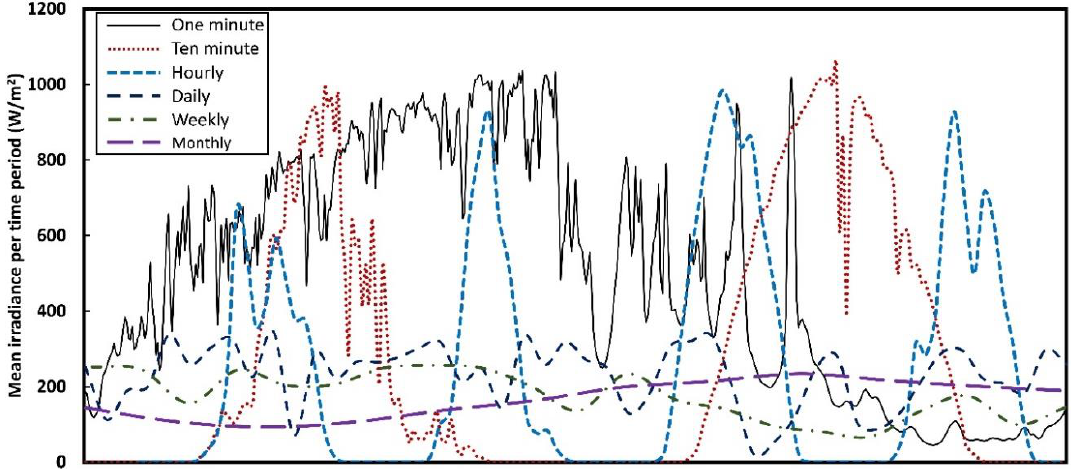
Figure 1. The variability of global horizontal irradiance (GHI) at Kookmin University, South Korea, as a function of time scale. The figure includes 1 day of 1 min data, 2 days of 10 min data, 4 days of 1 h data, 48 days of day data, and 12 months of monthly data.